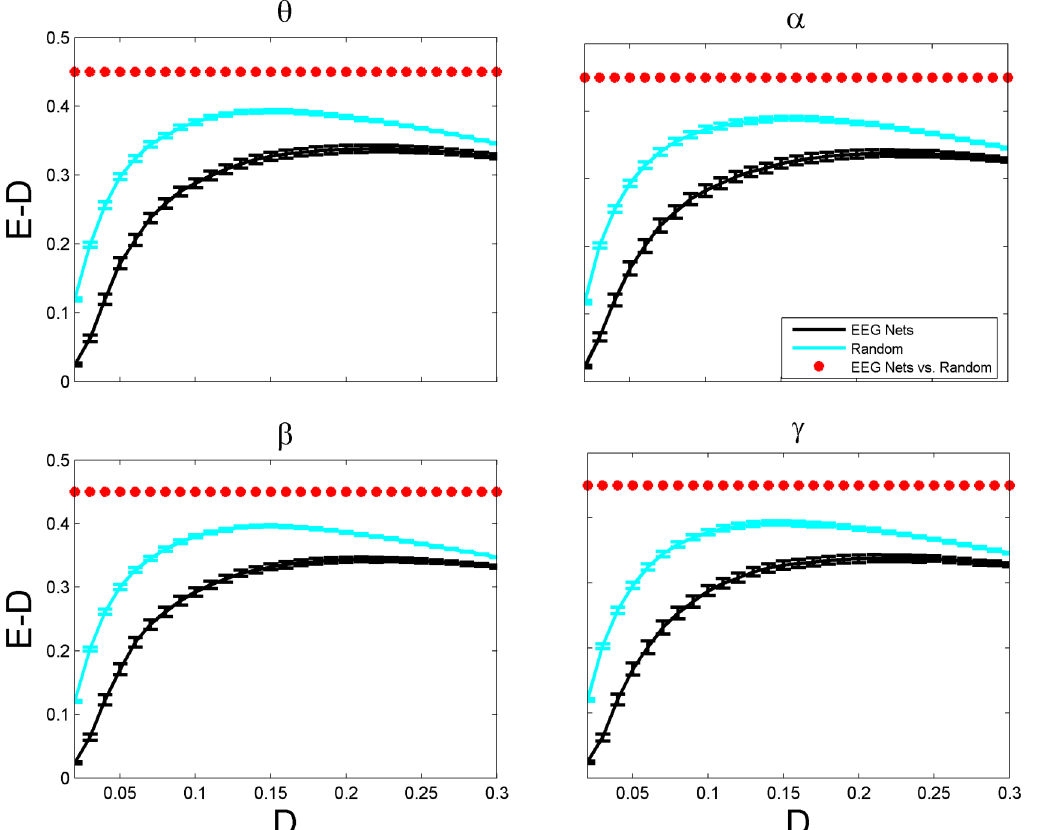
Fig 1. Efficiency-cost plots (Global Efficiency ( E ) minus Network Density ( D )) of EEG-based brain networks as a function of density values. Mean values with bars corresponding to the standard errors of the efficiency-cost curves are plotted for different frequency bands including theta (3 – 7 Hz), alpha (7 – 13 Hz), beta (13 – 30 Hz) and gamma (30 – 50 Hz).The graphs show the metrics for the functional networks obtained from EEG time series of 30 healthy subjects (black lines) and the randomized networks (cyan lines). The randomized networks have the same degree sequence as the original networks. The red asterisk above the plots represent the density value for which the two populations have significantly different median (Wilcoxon ’ s ranksum test; P < 0.05).